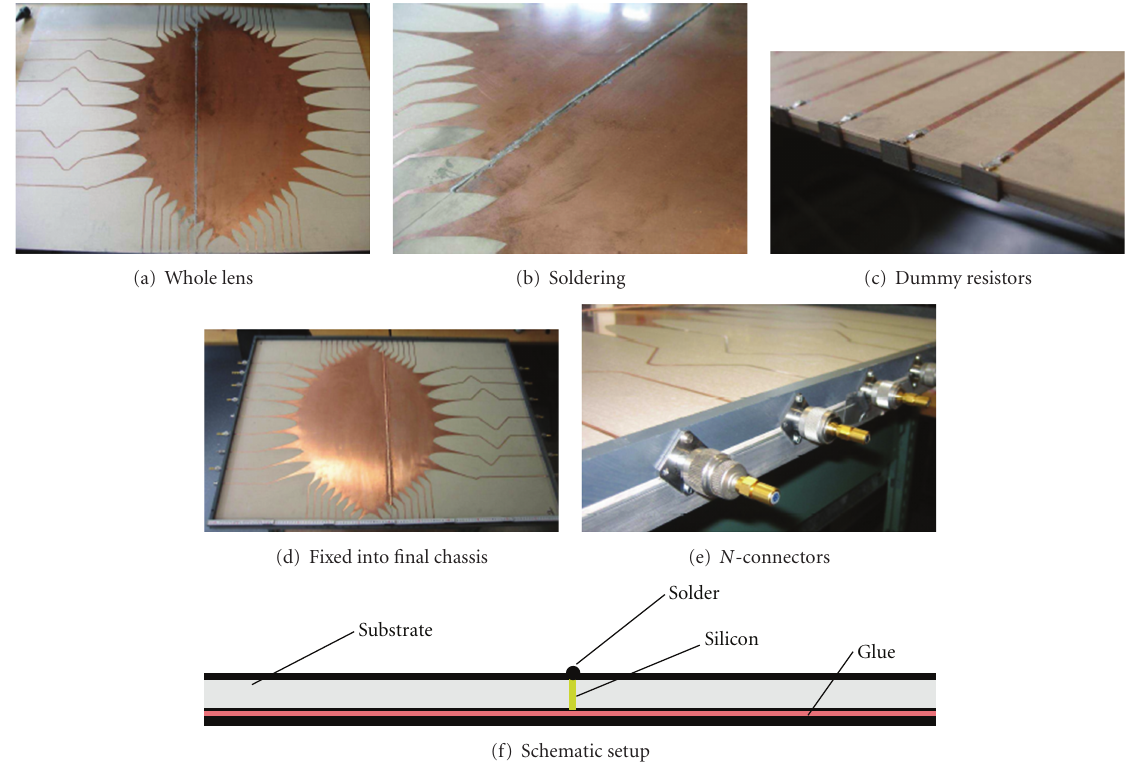
Figure 4: Mechanical setup of the Rotman